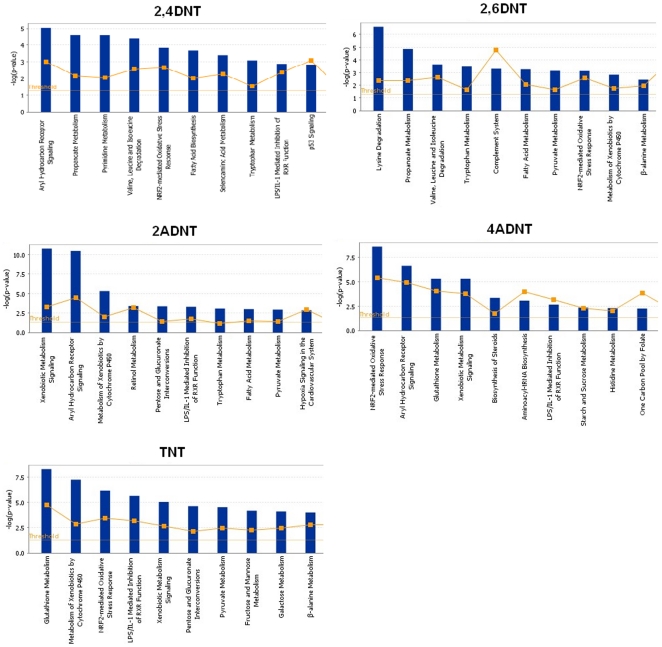
Most significantly canonical pathways regulated by the 5 compounds.Top ten pathways were selected to present for each compound. Most significantly regulated transcripts of each compound were chosen to run the Ingenuity pathway tool. The bigger the -log(p-value) of a pathway is, the more significantly the pathway is regulated. The threshold lines represent a p value with 0.05.